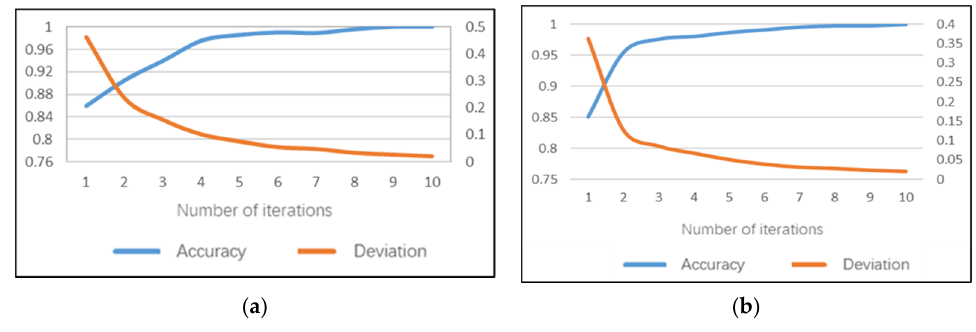
Figure 12. Training performance of smoking sub-model: ( a ) daytime; ( b ) night.